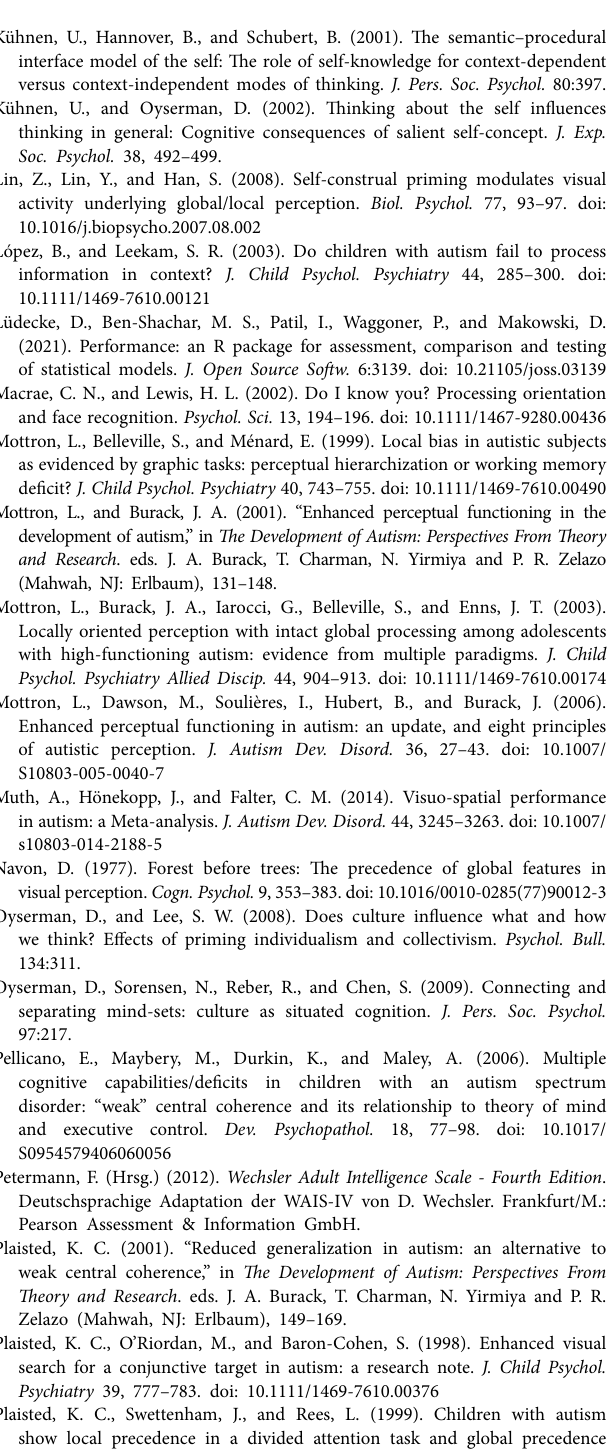
Figure-Disembedding in Autistic and Non-autistic